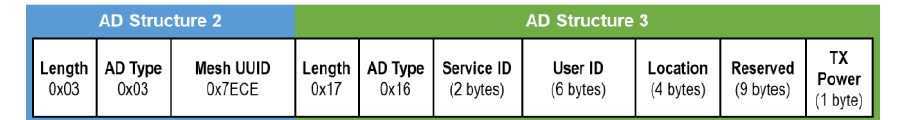
Figure 6. The message format for Type 3 and Type 4 messages.